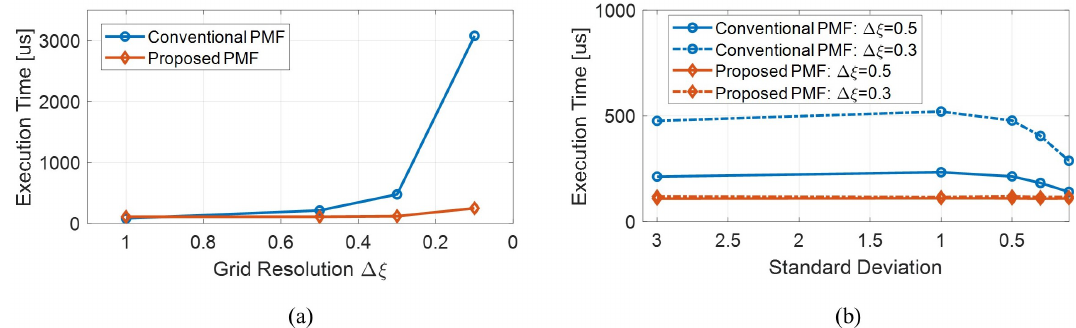
Figure 5. Comparison of the computation time between the conventional PMF and the proposed PMF for various grid intervals and process noise variances ( a ) computation times v.s. grid intervals ( b ) computation time v.s. process noise variances for two grid